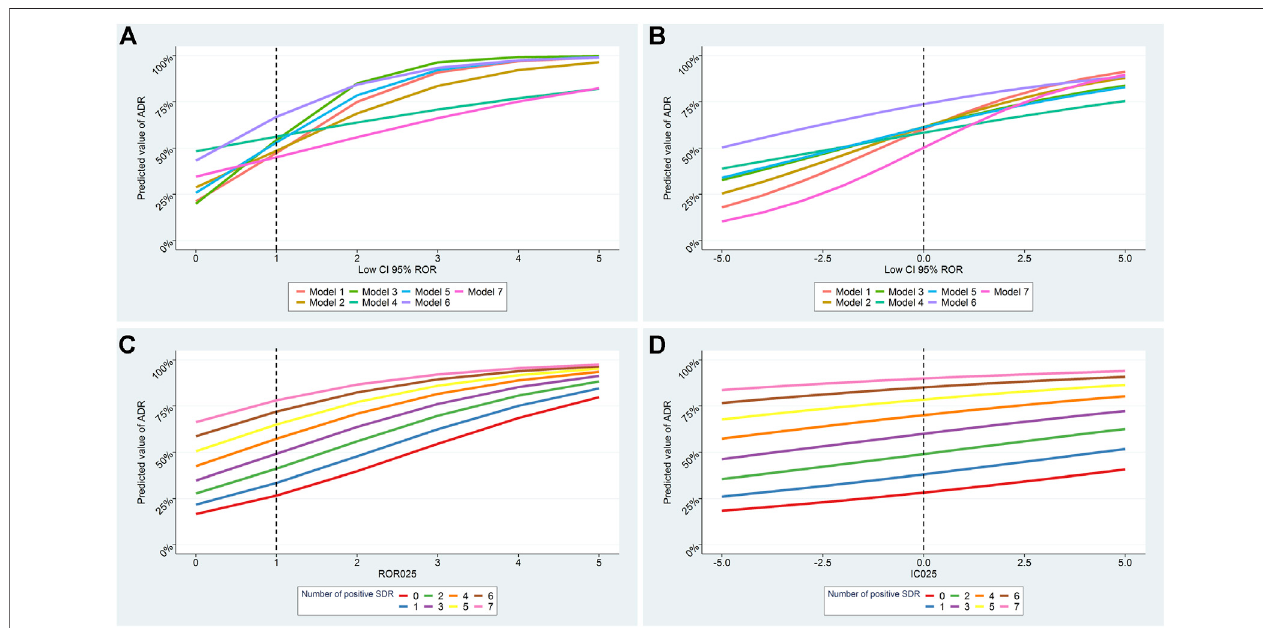
FIGURE3| Predictedprobabilityforasignalofdisproportionate reporting(SDR)tocorrespondtoatrueADRaccordingtothelowerboundaryofdisproportionality values and to the number of positive SDR. Results of all models according to number of positive SDR for ROR LB and IC LB are presented in A, B respectively. Results of model 1 according to the number of positive SDR for ROR LB and IC LB are presented in C, D . Model 1: only suspect cases included; Model 2: subgroup by country (United States); Model 3: reporting by health professionals only; Model 4: subgroups by therapeutic area; Model 5: serious cases only; Model 6: within 5 years of drug approval; Model 7: suspected and concomitant